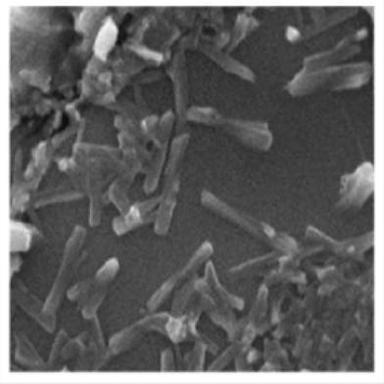
SEM images of unexposed and exposed samples of STS ChGA: (a) 0 kGy, (b) 4 kGy, (c) 8 kGy, (d) 12 kGy.